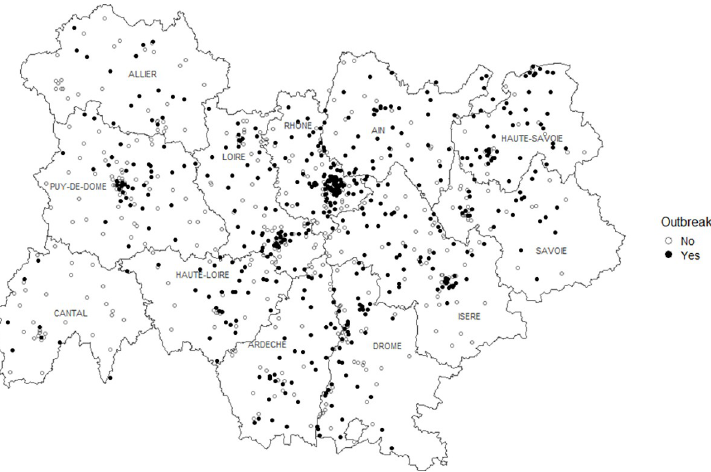
Fig 1. Locations of the nursing homes of Auvergne-Rhoˆne-Alpes Region, France, March 1–July 31, 2020. Black and white circles indicate, respectively, the nursing homes with and without COVID-19